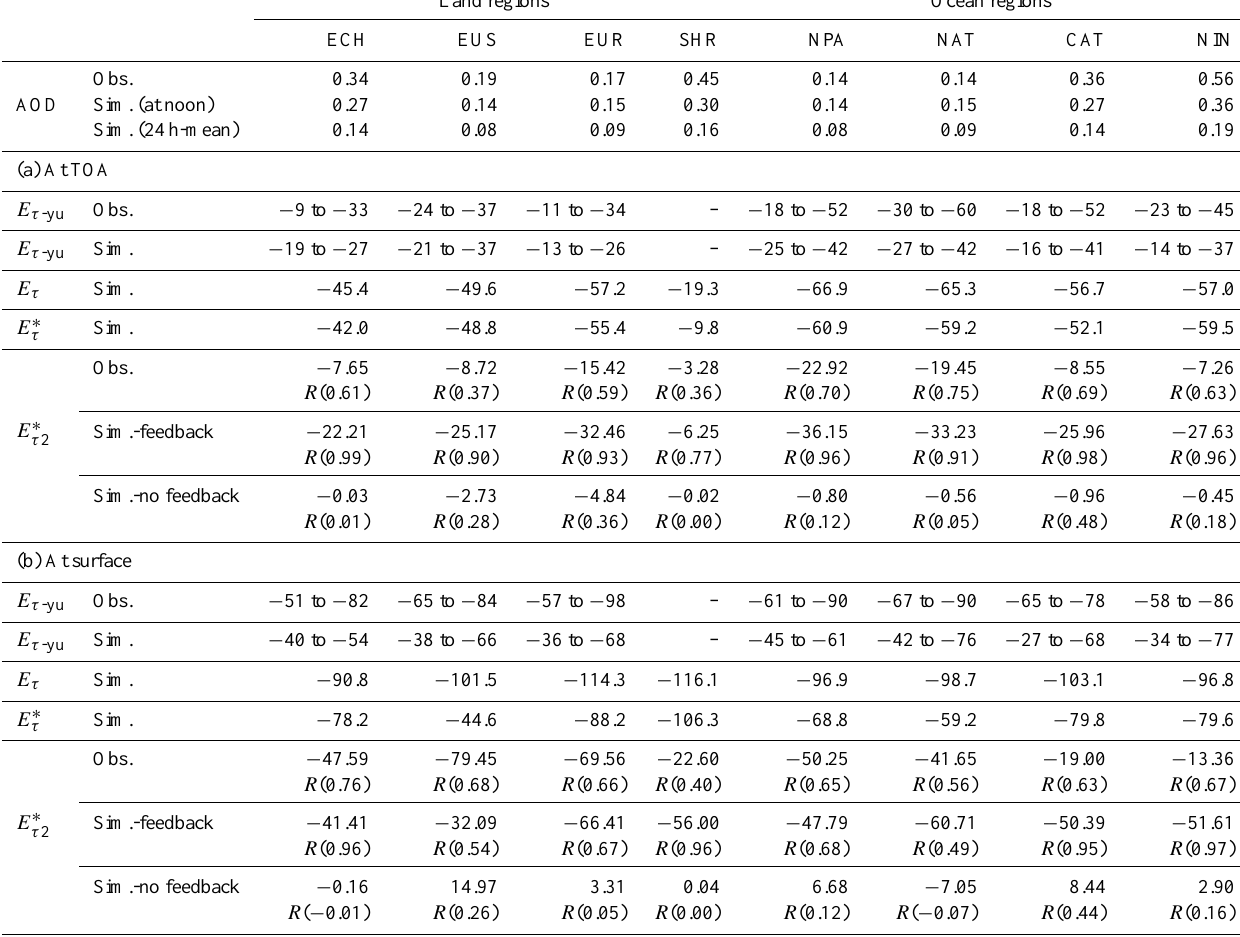
Table 5. Estimates of summertime aerosol direct radiative efficiency ( E τ , Wm − 2 τ − 1 ) averaged for 2000–2010. Land regions Ocean regions ECH EUS EUR SHR